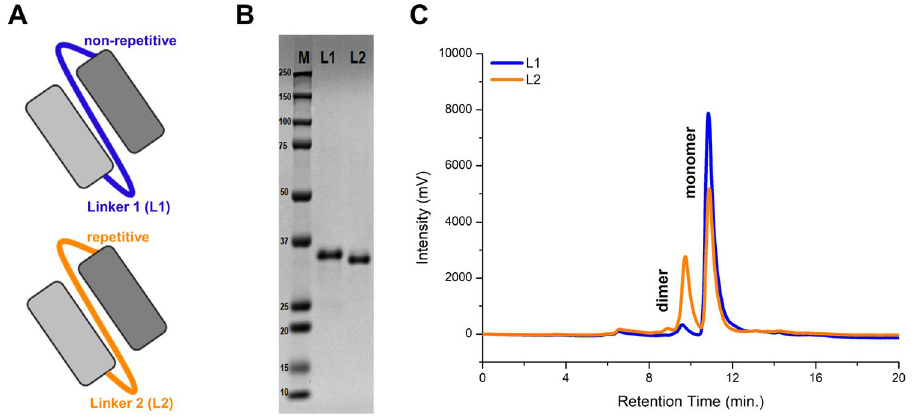
Figure 1. ( A ) Schematic representation of designed L1 and L2 scFvs. ( B ) SDS-PAGE analysis of purified L1 and L2. Full image of the SDS-PAGE gel is provided in Supplementary Figure 1. ( C ) SEC chromatograms of L1 (blue) and L2 (orange) from SE-HPLC analysis.